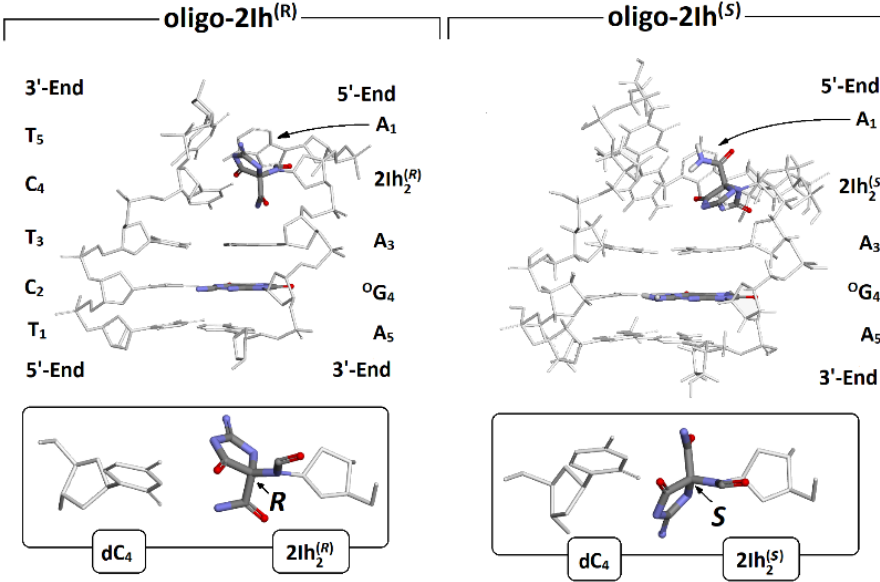
Figure 2. Graphical representation of optimized oligo-2Ih (R) , oiligo-2Ih (S) spatial geometries, ex- tracted from double helix base pairs formed by hydantoin and cytidine.